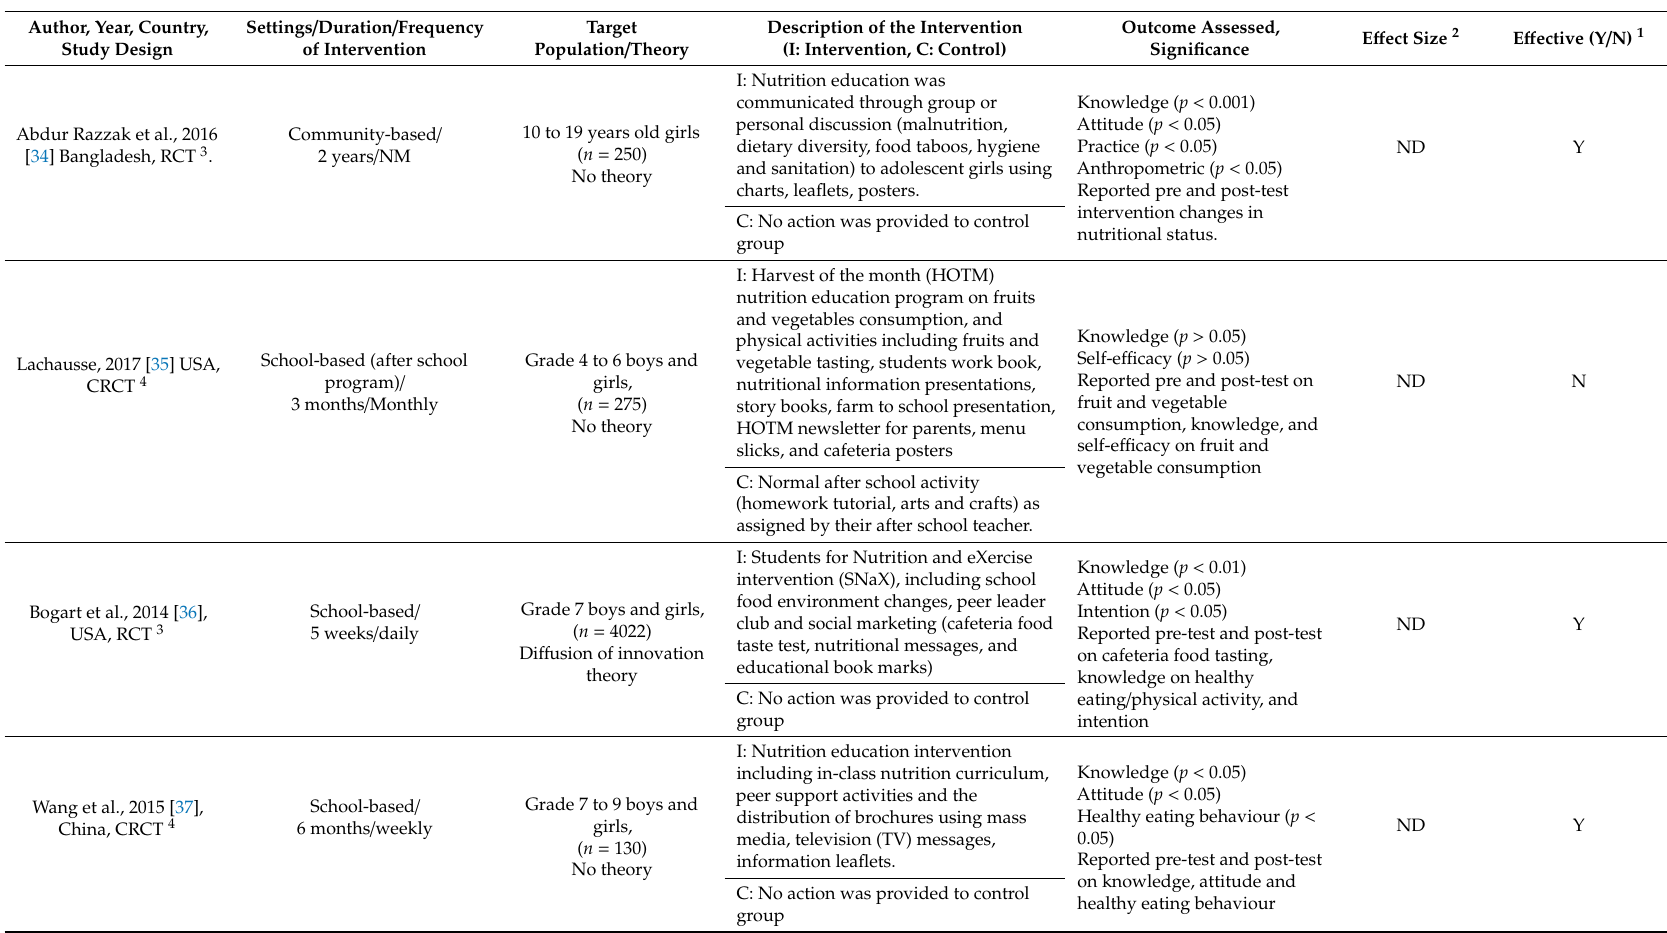
Table 1. Summary of intervention to improve knowledge, attitudes and practices among adolescents on